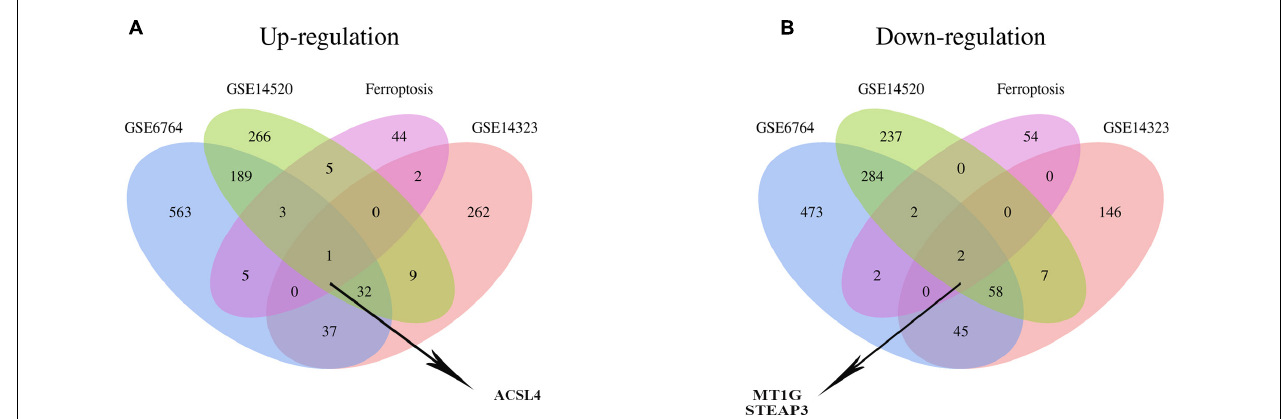
FIGURE 1 | Identification of the co-DEG between three GEO datasets and the ferroptosis-related gene dataset. The number in every overlapping part meant the amount of differentially expressed genes. (A) One differentially expressed gene, namely ACSL4, was identified to be up-regulated in four datasets. (B) Two differentially expressed genes, including MT1G and STEAP3, were down-regulated in four